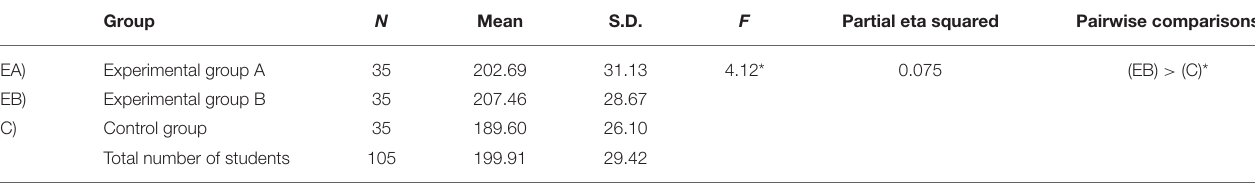
TABLE 5 | ANCOVA results of learning achievement on the followup-test scores of the three groups. Group Experimental group A Experimental group B Control group